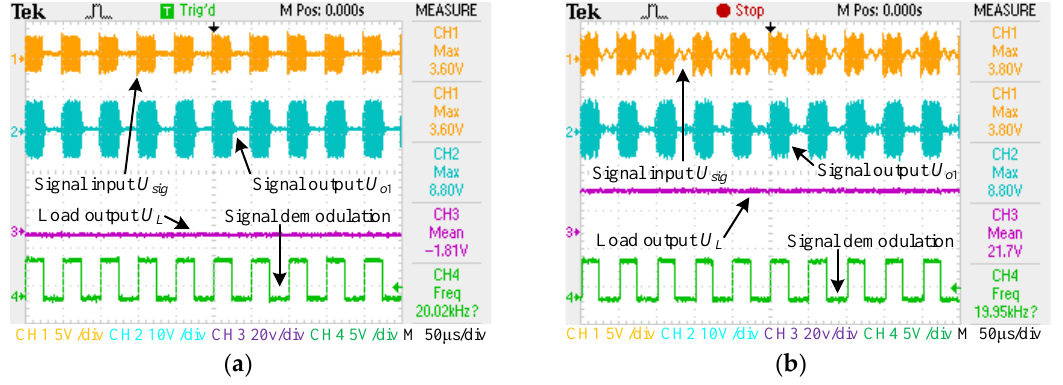
Figure 16. Waveforms of the data transmission at optimal parameters ( a ) without power transmission; ( b ) with power transmission.